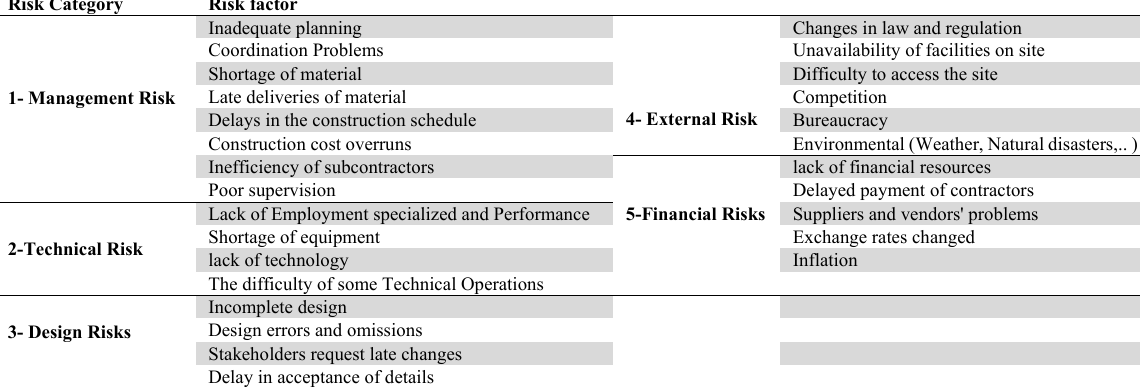
Classification of risk factors according to previous studies into five classifications: management risk, technical risk, design risks, external risk, and financial risks (Source,